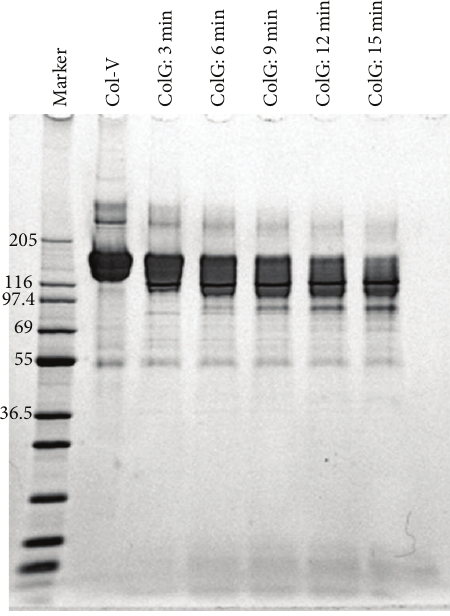
Figure 3: SDS-PAGE analysis of Col-V digestion by ColG within 15 min.